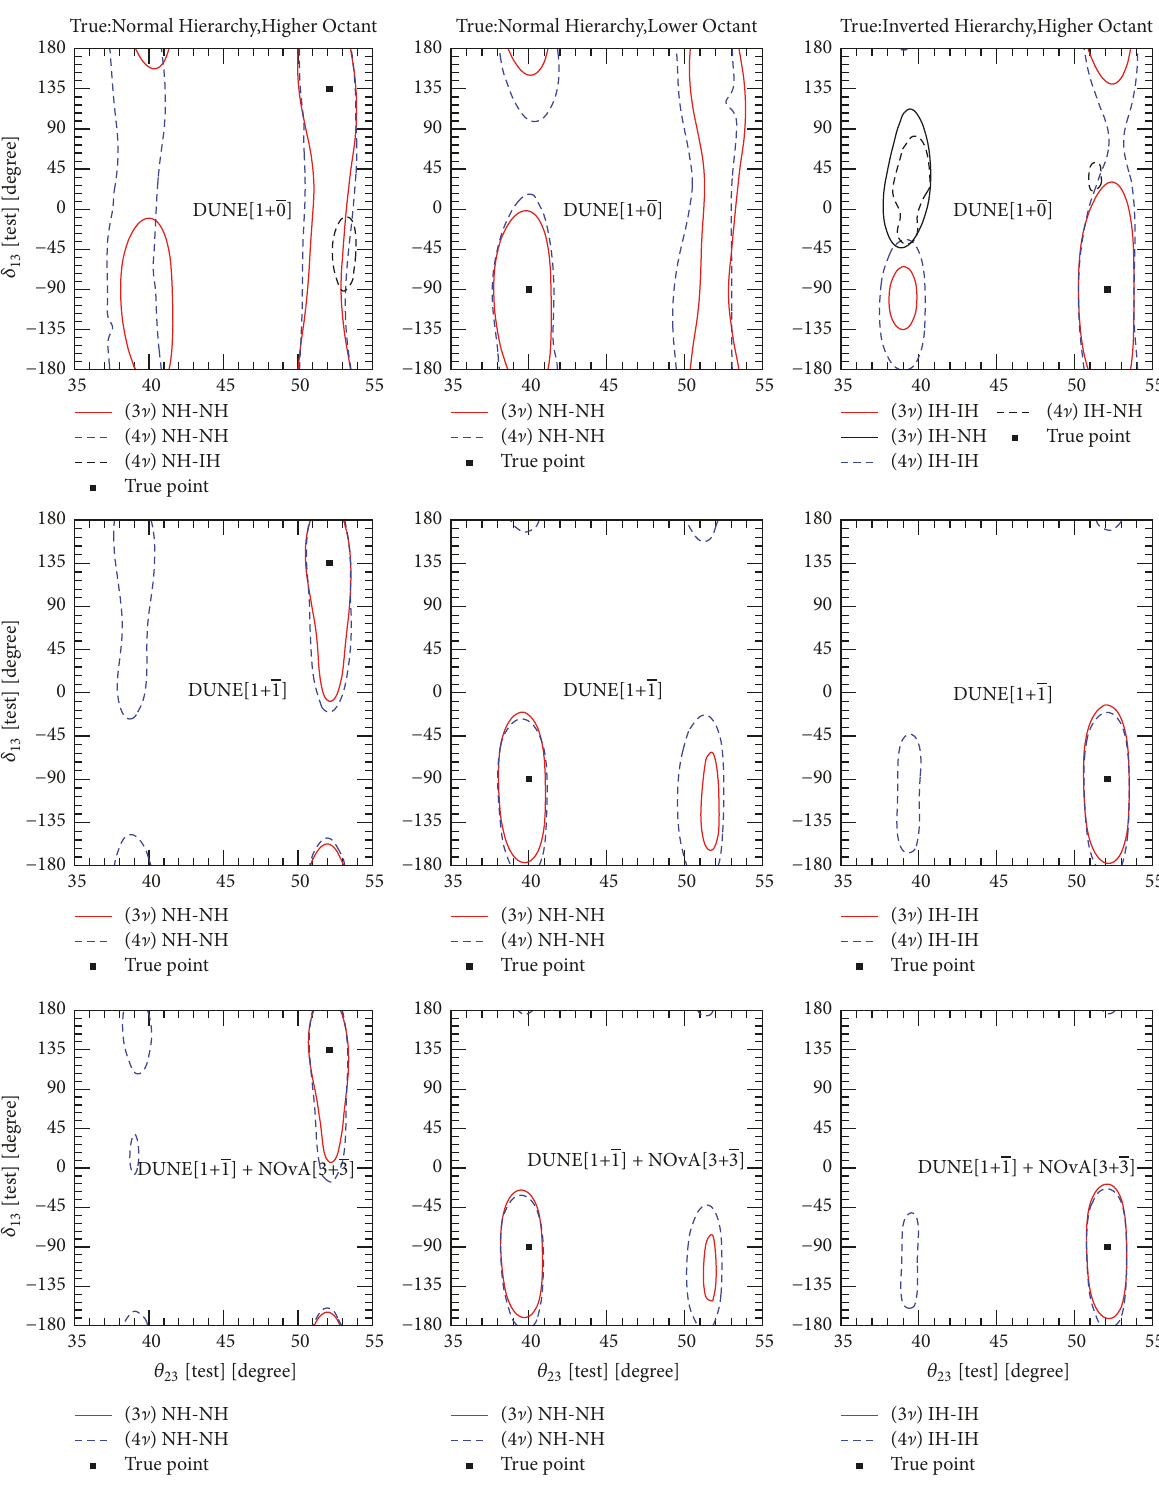
Figure 4: Contour plots of allowed regions in the test plane 𝜃 23 versus 𝛿 13 at 99% C.L with top, middle, and bottom rows for DUNE runs of 1 + 0, 1 + 1 years and DUNE [1 + 1 ]+NO ] A [3 + 3 ],